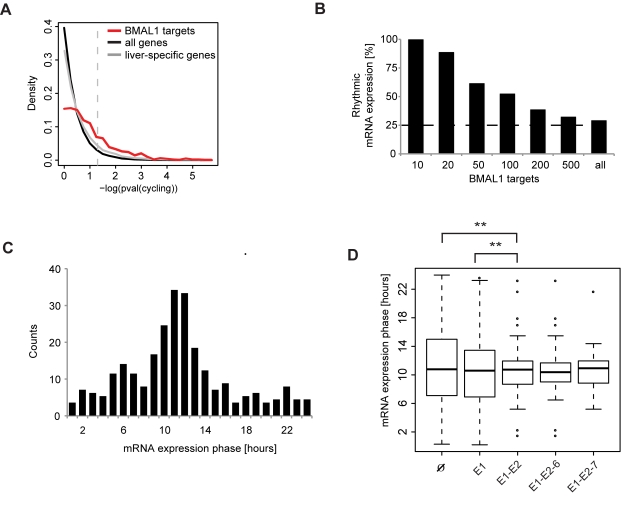
mRNA expression profiles of BMAL1 targets.(A) BMAL1 targets are highly enriched for robustly cycling mRNAs. Distribution of –log10 (p-value) are shown for all genes (black), liver-specific genes (see Materials and Methods) (grey), and BMAL1 targets (red). The vertical dashed line represents p = 0.05. Expression data are from mouse liver light-dark time course data [31]. BMAL1 sites were annotated with the closest protein-coding transcript in Ensembl within a window of 10 kb. (B) Strong BMAL1 binding is associated with circadian mRNA accumulation. The sites are ranked according to their strength, and the fraction of robustly circadian mRNA patterns (Fisher test, p<0.05; see Materials and Methods) among the top x sites is shown. This fraction decreases from 100% among the top 10 sites to 29% for all sites, and this proportion is practically unchanged (31%) if we restrict our analysis to only rhythmic BMAL1 sites. (C) The distribution of the phase of cytosolic mRNA expression of targets of BMAL1 peaks at ZT10-ZT12. (D) BMAL1 targets with an E1-E2 element show narrower mRNA phase distribution than targets with no or single E-boxes (Rao homogeneity test for circular data [60], p[equality of dispersions]<0.01). E1-E2-6 and E1-E2-7 represent, respectively, the subgroup of E1-E2 sites with a spacer of 6 bp and 7 bp.